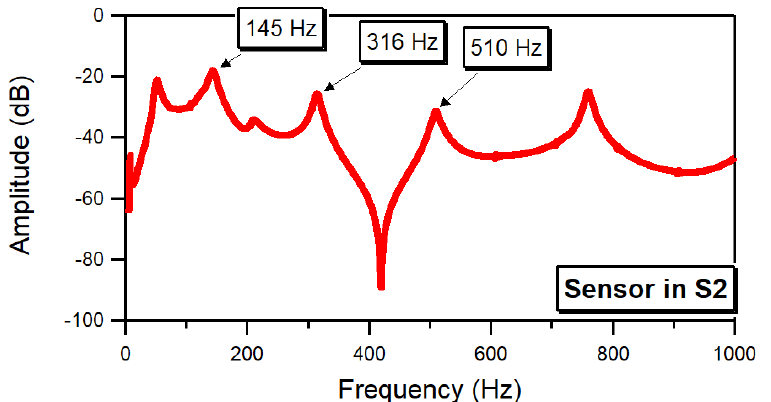
Figure 6. Spectral response of the beam at the low frequency range acquired at position S2. A similar experimental procedure was repeated to characterize the response of the composite beam when subjected to a high frequency excitation. In this case, a linear sweep sine signal varying between 10 and 30 kHz in 6 s was used to drive the low-profile piezoceramic transducer bonded at location A1. The vibration of the system was acquired at the two locations S1 and S2 and then processed to obtain the spectral response of the beam at the two positions. The spectra, shown in Figure 7, show a reasonably wide region of high amplitude values in the proximity of the 21,070 Hz frequency for both the responses measured at the S1 and S2 positions. Therefore, a fixed frequency of 21,070 Hz was selected for the probe excitation of the subsequent VAM tests. The position S2, which is distant from the nodes for each of the three examined mode shapes (Figure 4), was chosen as the location for the impact, so as to ensure that sufficient strain energy is available at the damage location to activate the nonlinearities generated by the fracture